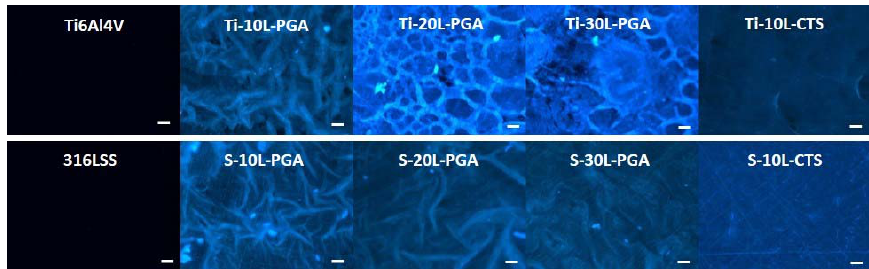
Figure 6. Fluorescence microscopy images of the MG63 cells seeded on different layers of C/PGA on Ti6Al4V and 316LSS substrates for one day and stained with Hoechst 33258. The scale bars are labeled in white with the length of 100 μ m.